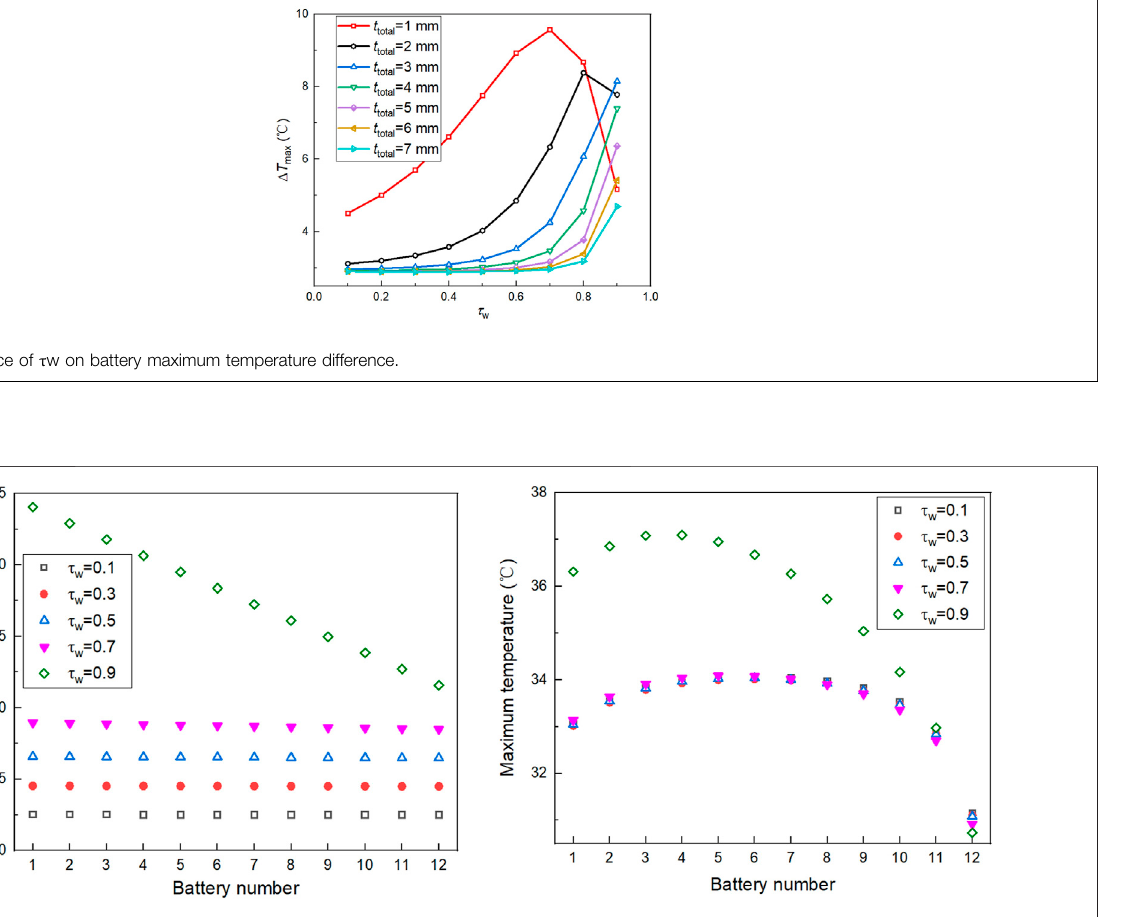
FIGURE 9 | (A) Effective thermal resistance at different τ w. (B) Battery cell temperature at different τ w.